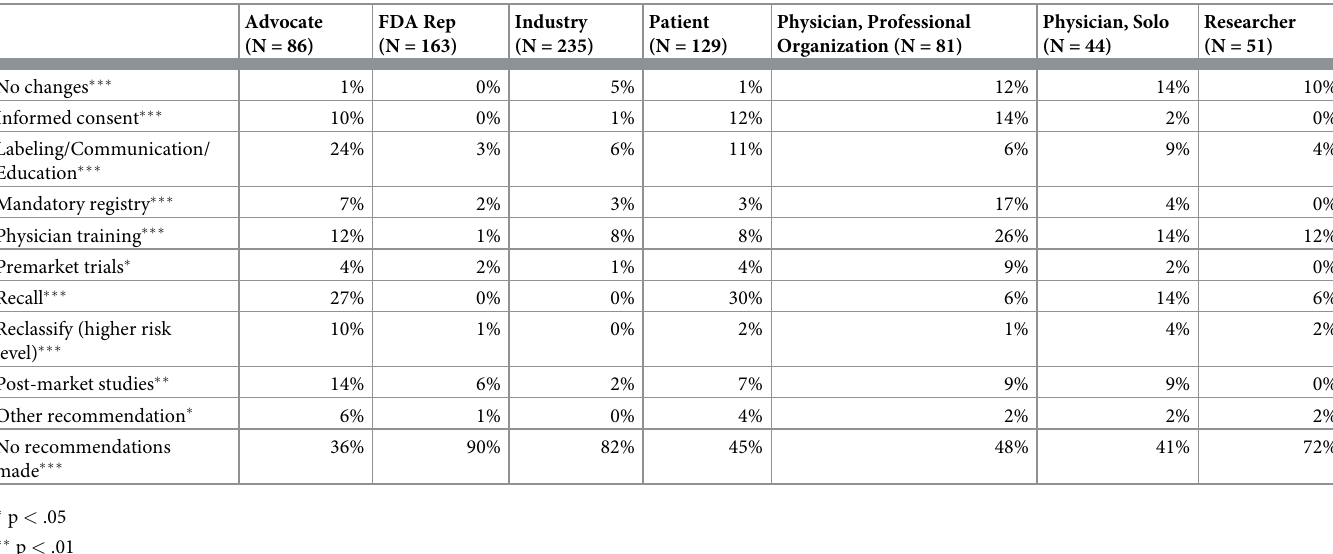
Table 5. Types of recommendations by speaker type (N = 789) 1